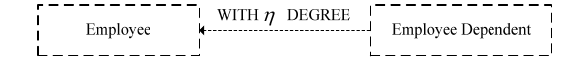
Fig. 4. Representation of a fuzzy dependency in a fuzzy UML model.